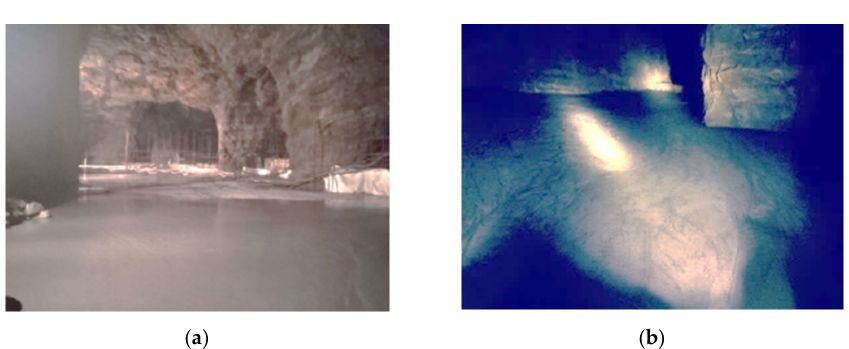
Figure 20. ( a ) Filter pipe arrangement; ( b ) Mining flow law in subsequent stope.